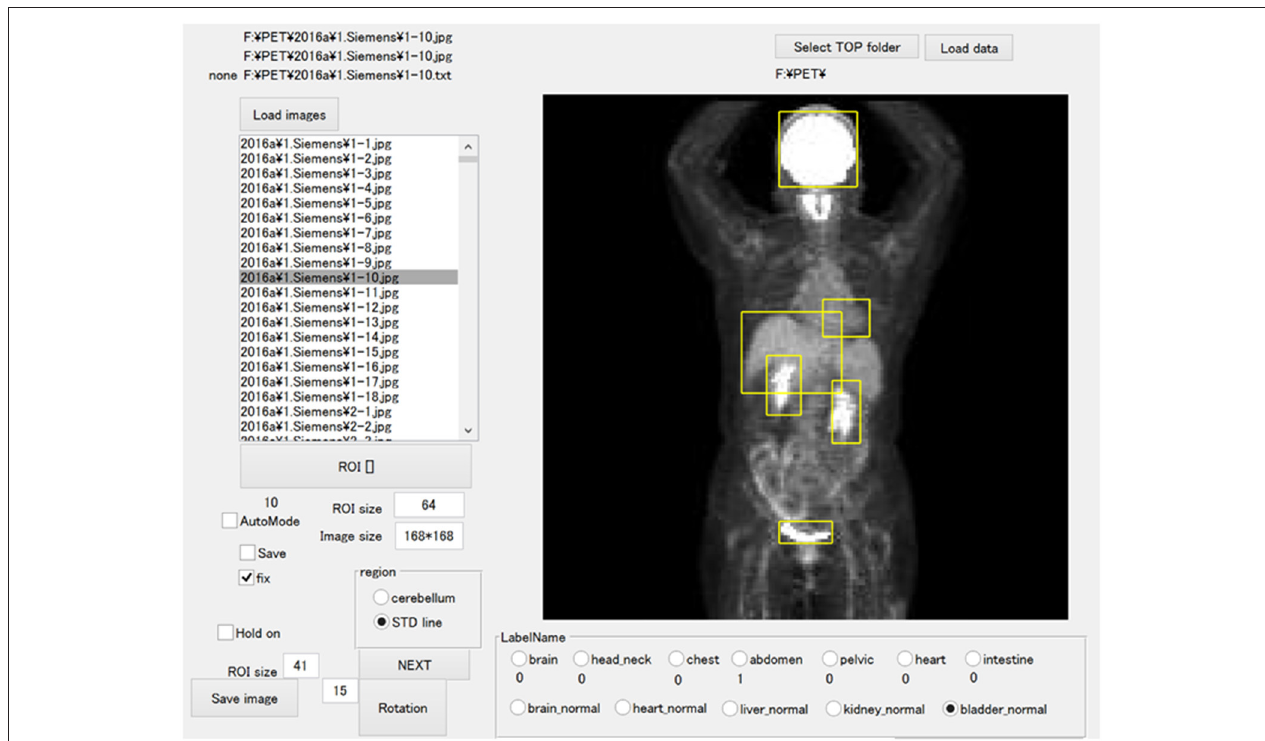
FIGURE 1 | The software for training outlined ROIs over the physiological uptakes. The yellow bounding boxes enclose physiological uptakes.